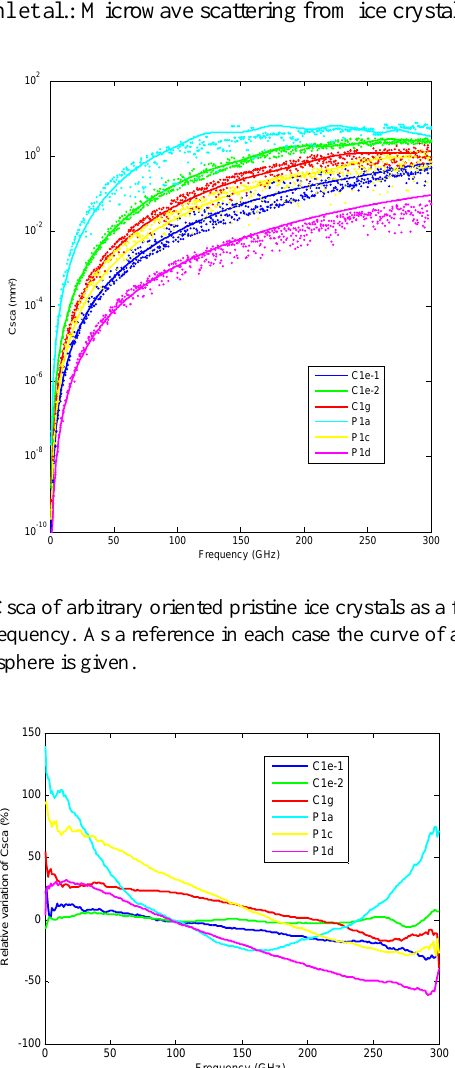
Fig. 7. Cabs of arbitrarily oriented pristine ice crystals as a function of the frequency. As a reference in each case the curve of an equal volume sphere is given.